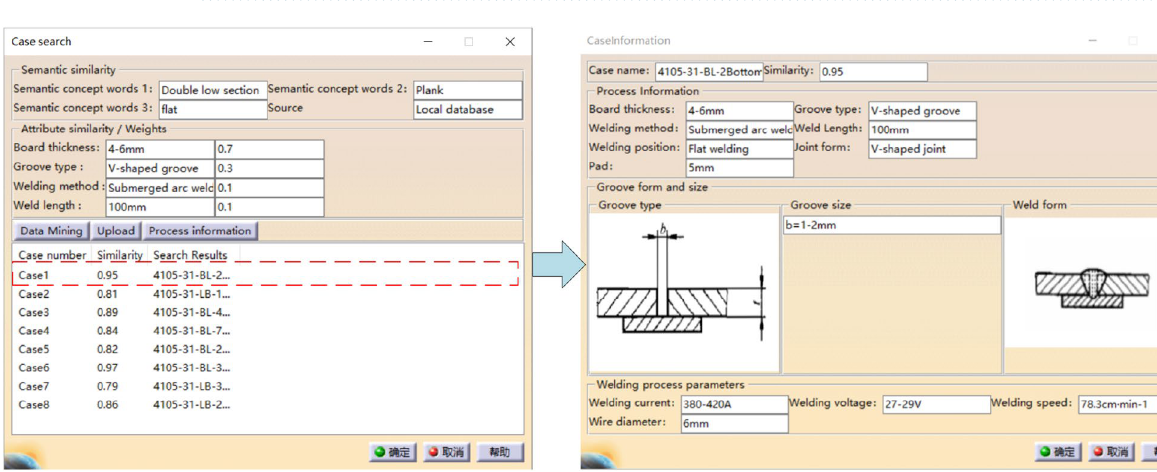
Figure 11. Case search and reuse module